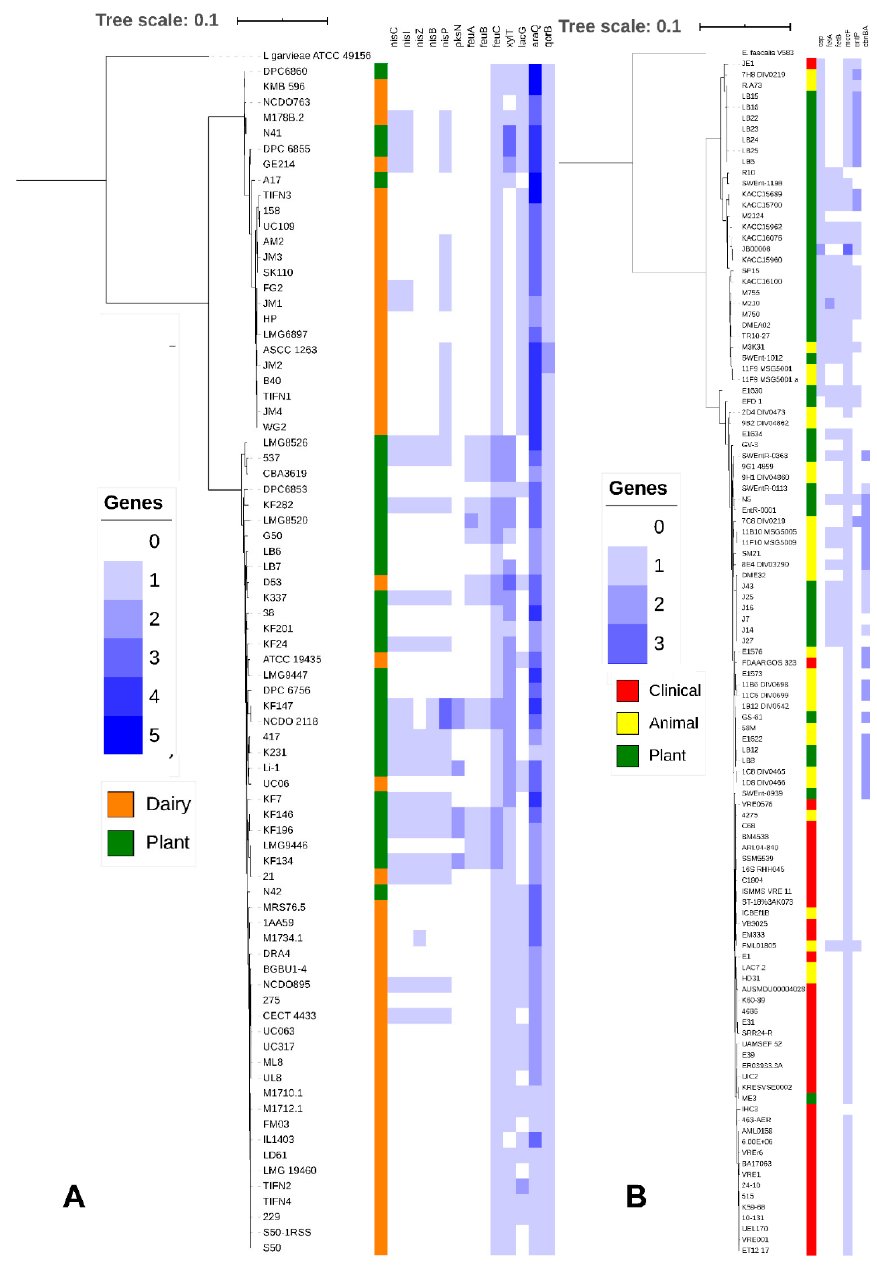
Figure 5. ( A ) Core genome tree of 77 Lactococcus lactis genomes. Genomes from L. lactis strains isolated from Dairy (Orange) and Plants (Green) are indicated, Lactococcus garvieae ATCC 49156 was included as an outgroup. A heatmap was generated indicating copy number of genes involved in nisin production ( nisC , nisI , nisZ , nisB , and nisP ), surfactin production ( PksN ), iron uptake ( feuA , feuB , and feuC ), xylose utilization ( xylT ), lactose utilization ( lacG ), arabinose utilization ( araQ ) and phenolic metabolism ( qorB ). ( B ) Core genome tree of 111 Enterococcus faecium genomes. Genomes from E. faecium strains isolated from clinical sources (Red), animals (Yellow), and plants (Green) are indicated, Enterococcus faecalis V583 is included as an outgroup. A heatmap was generated indicating the copy number of genes involved in cold shock response ( csp ), iron uptake ( fetA , fetB ), microcin ( mccF ), enterocin ( entP ), and carnobacteriocin ( cbnBA Dairy isolates of L. lactis strains were dispersed in the tree but clustered in areas, representing L . lactis subsp. cremoris (upper cluster) and L. lactis subsp. lactis (lower cluster) (Figure 5A). Plant isolates of L. lactis were identified in both subspecies but pre- dominantly belonged to L. lactis subsp. lactis . Over 2000 genes were differentially dis-